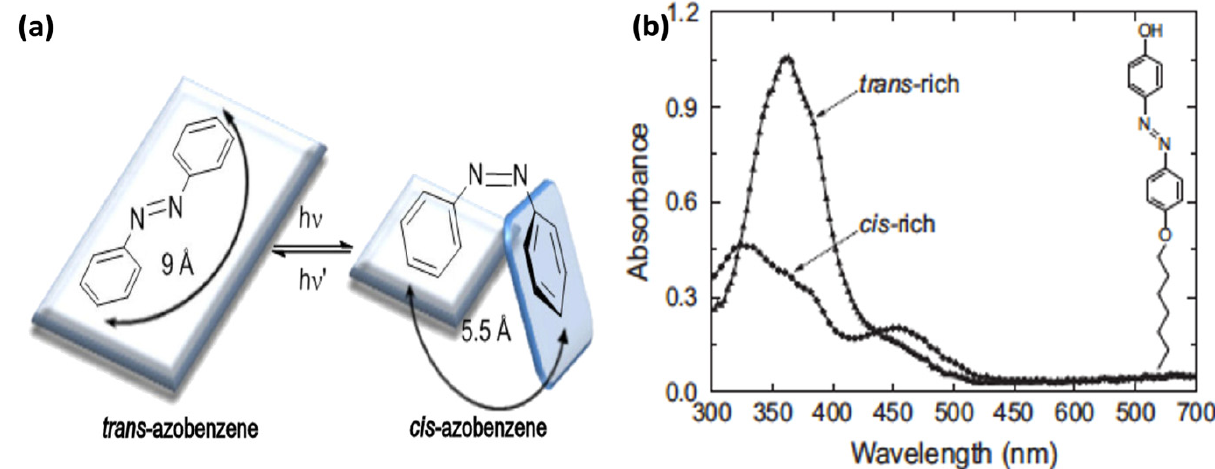
Figure 4. ( a ) Trans–cis isomerization of azobenzene [66]. ( b ) Absorption spectra of the trans-rich and cis-rich photo sta- tionary states of 4-(4 ′ -heptyloxyphenyl) azophenol, shown in the inset. The spectra are measured from a polymeric thin film before and after irradiating with a circularly polarized 375 nm diode laser [71].